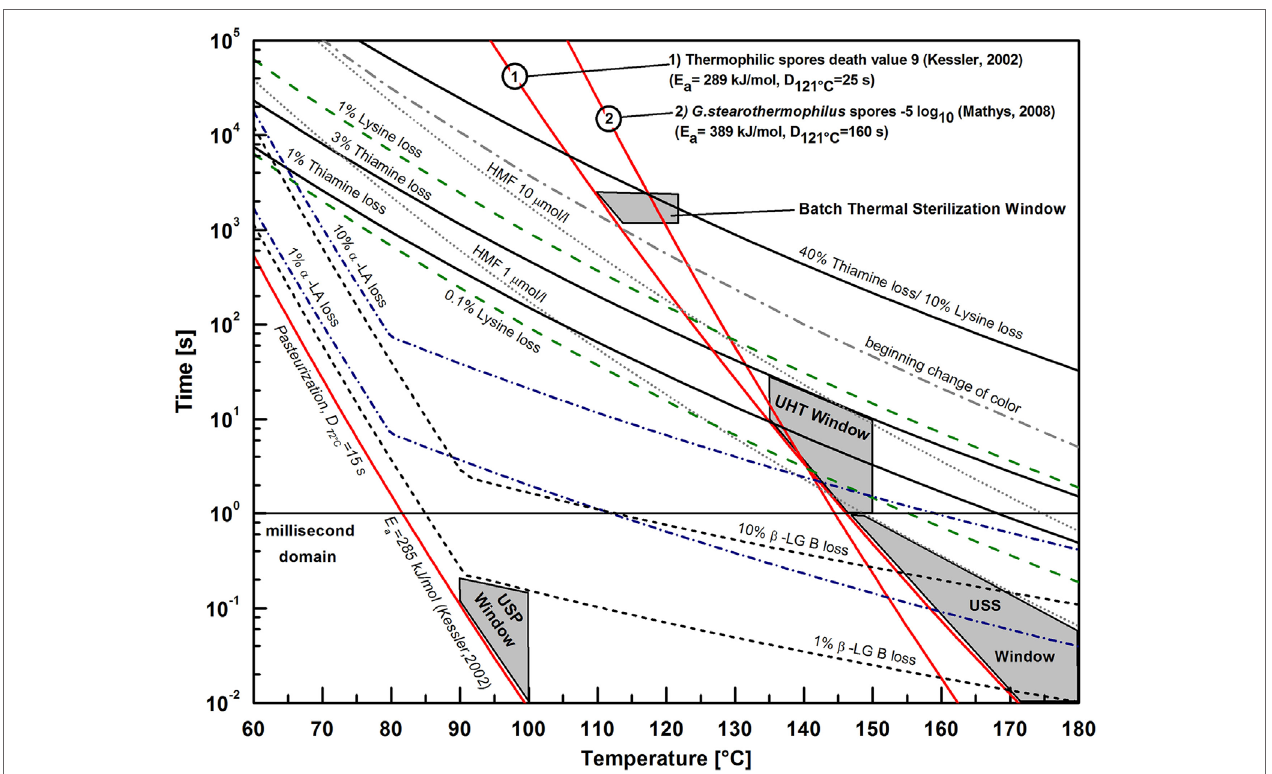
FiGUre 1 | Characterization of process windows for thermal preservation (pasteurization and sterilization) with respective wanted microbial and unwanted biochemical effects with milk as the model system, as modified from Kessler (14). Process windows above 1 s belong to conventional treatments and process windows below 1 s (ultra-short pasteurization and ultra-short sterilization) can be used as new treatments based on micro structured reaction